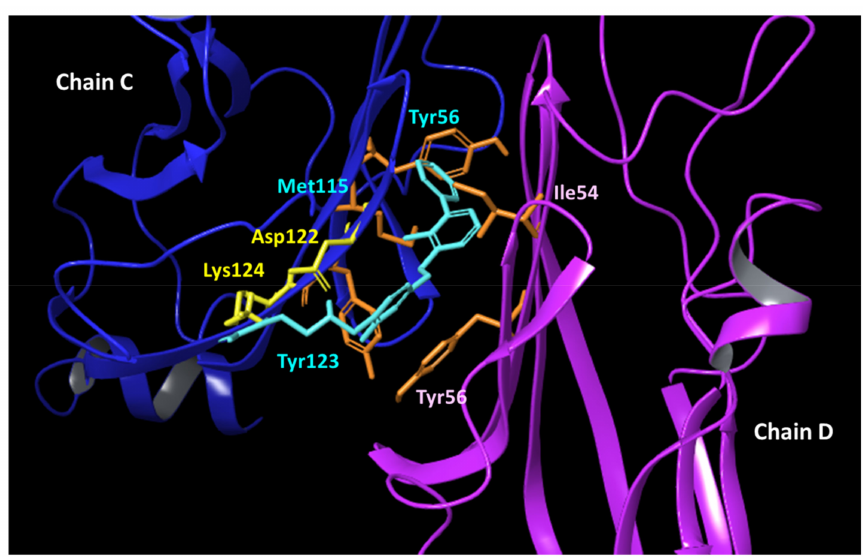
Figure 2. Crystal structure of PD-L1 dimer (chains C and D) bound to BMS-202 ( 5 ; PDB code 5J89). Ligand ( 5 ) is shown with cyan sticks. Hydrophobic residues of the binding cavity are highlighted in orange sticks (chain C: Tyr56, Met115, Tyr123; chain D: Ile54, Tyr56). Residues Asp122 and Lys124 (chain C) are shown with yellow